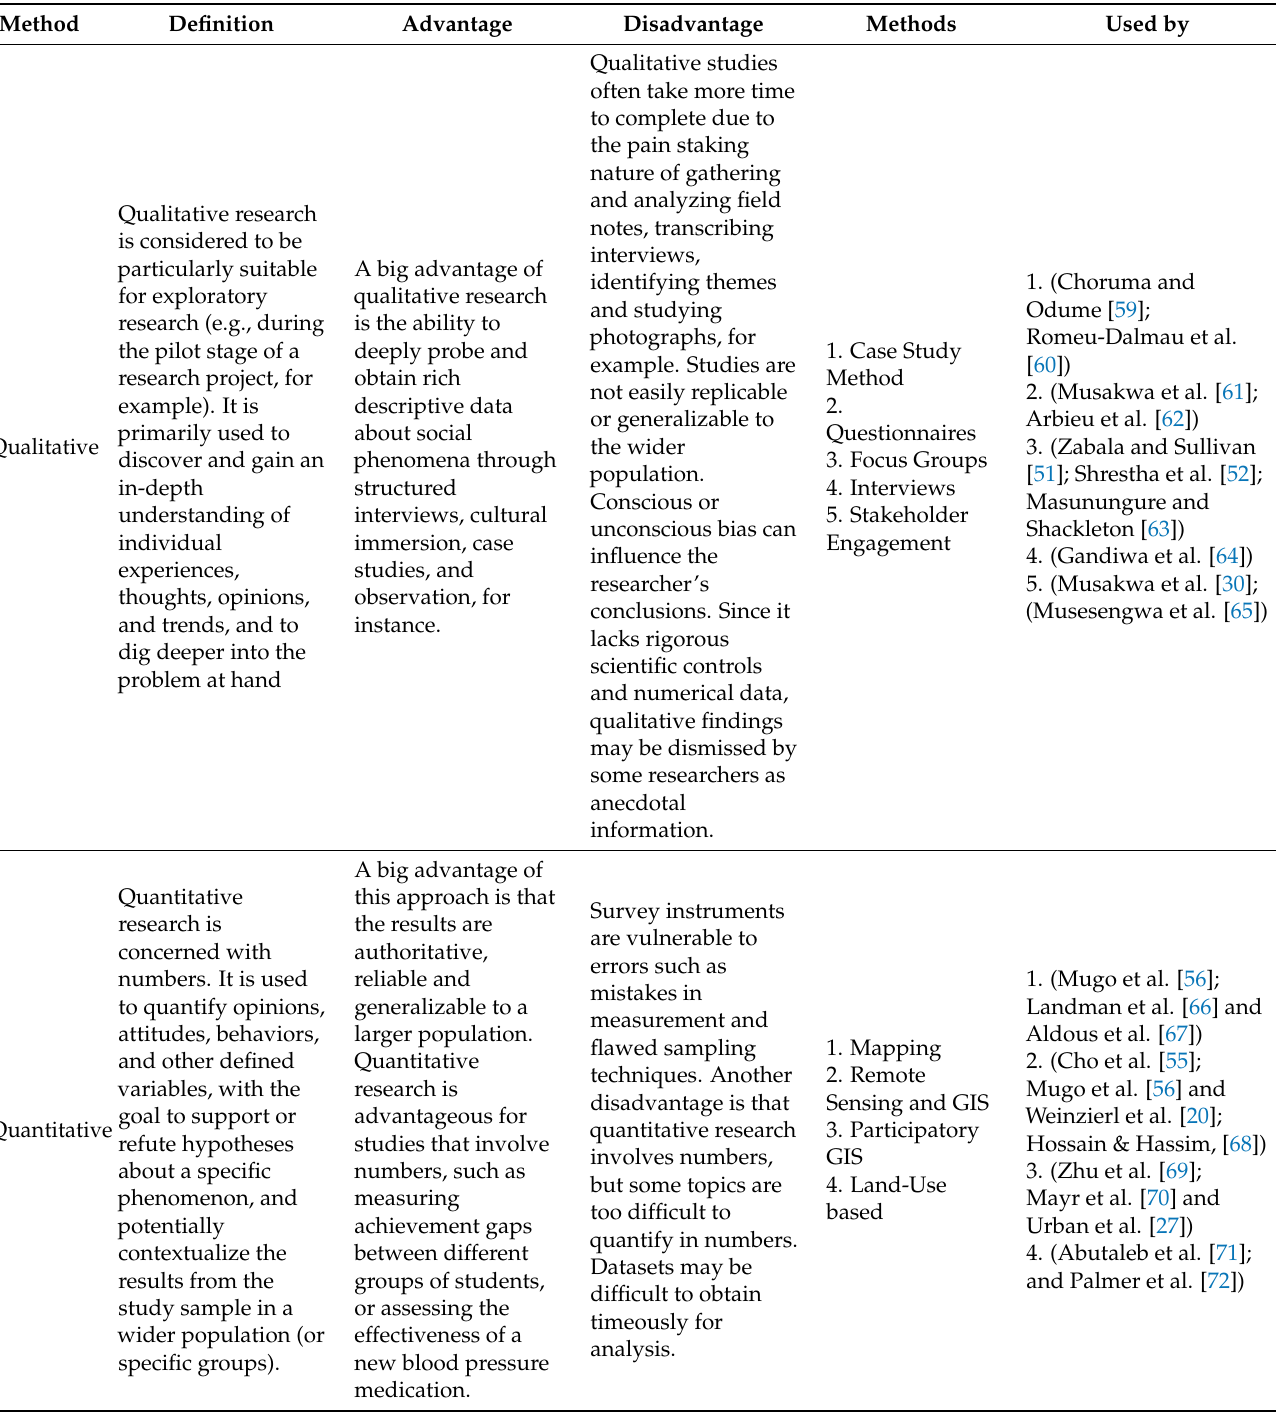
Table 7. Comparison of major methods used for ES research, adopted from Ignatieva et al.